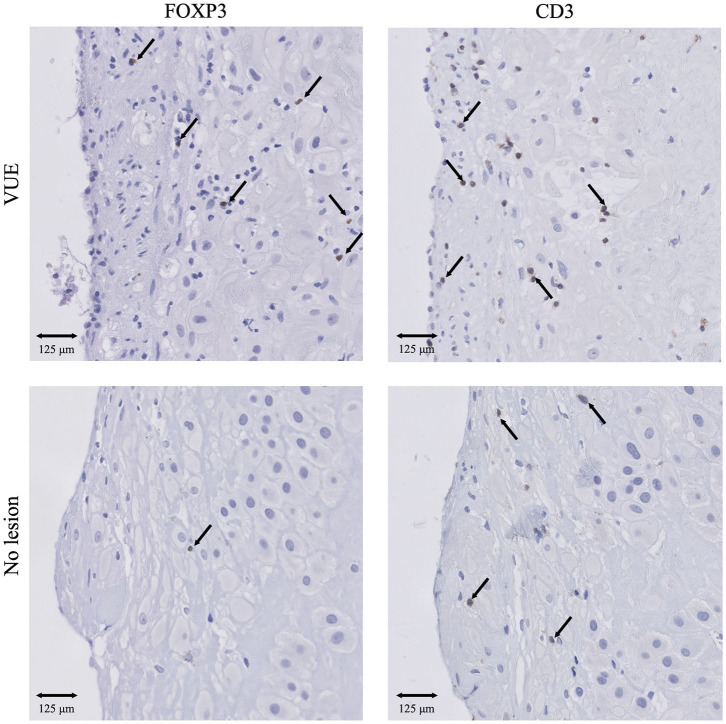
IHC results of Treg cells and T cells in VUE and no lesions in the FGR cohort. Presence of CD3+ T cells and FOXP3+ Treg cells in VUE (n = 45) and no lesion (n = 44) within the FGR cohort. 20x magnification. Arrows indicate all FOXP3+ cells. Arrows set as example for CD3+ T cells, not all positive cells are indicated. FGR, fetal growth restriction; VUE, villitis of unknown etiology.